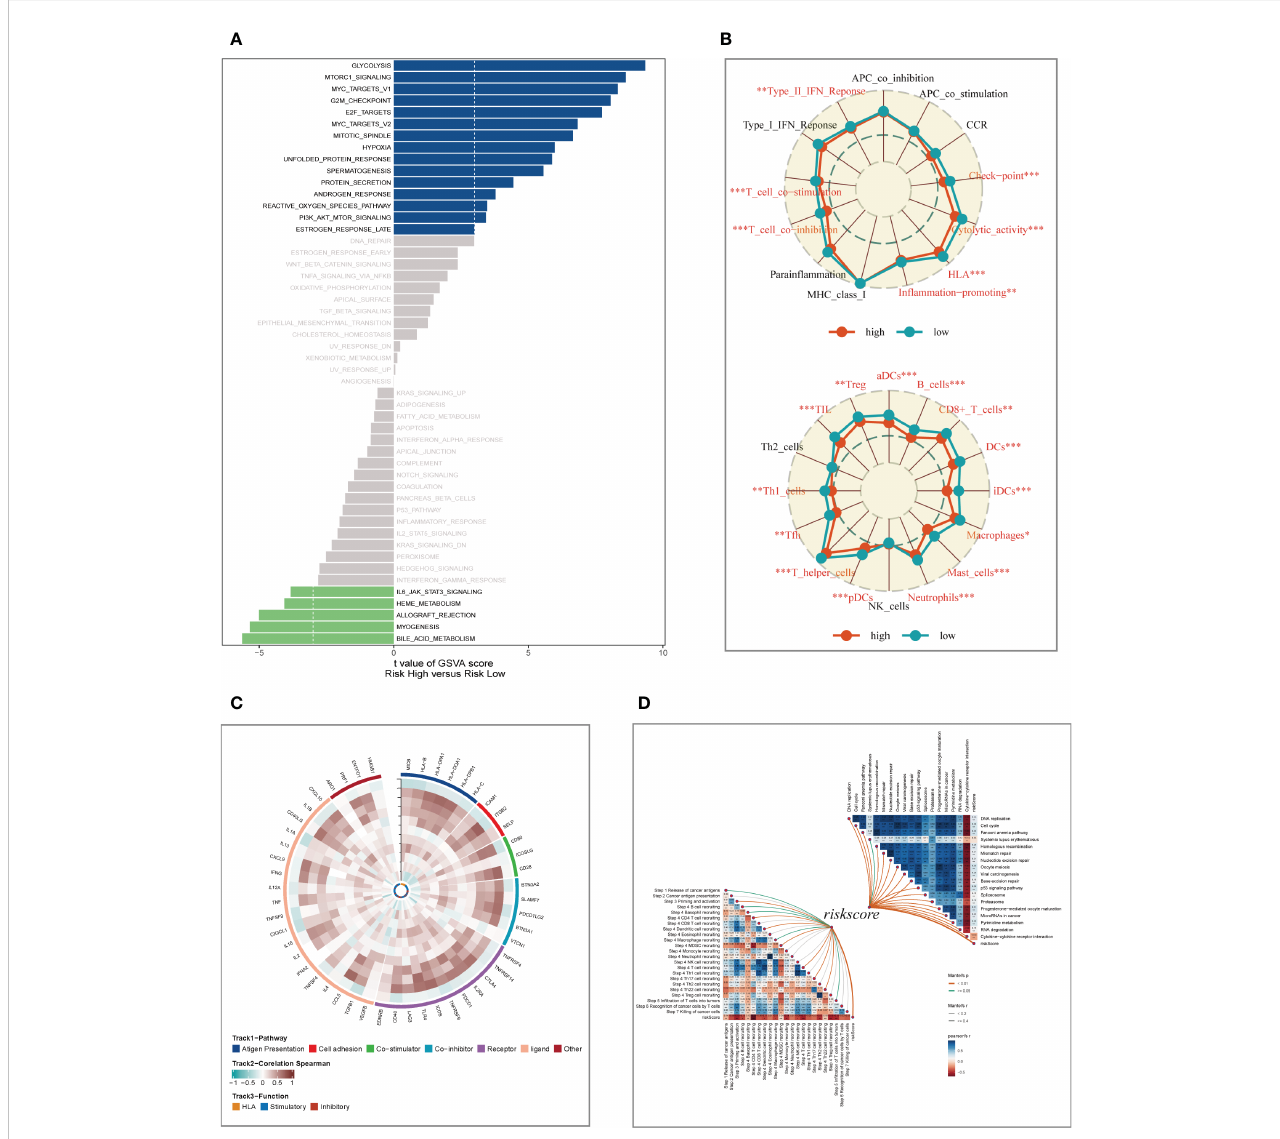
FIGURE 7 Enrichment analysis and functional annotation. (A) GSVA shows the enrichment of hallmark gene sets in different risk subgroups. (B) The ssGSEA algorithm was used to evaluate the differences in immune cells and immune-related functions between high- and low- risk subgroups. (C) Heat map of correlation between model genes and immune genes. (D) Correlation of risk scores with ICB response signature and each step of the tumor-immune cycle. *P < 0.05, **P < 0.01, ***P <